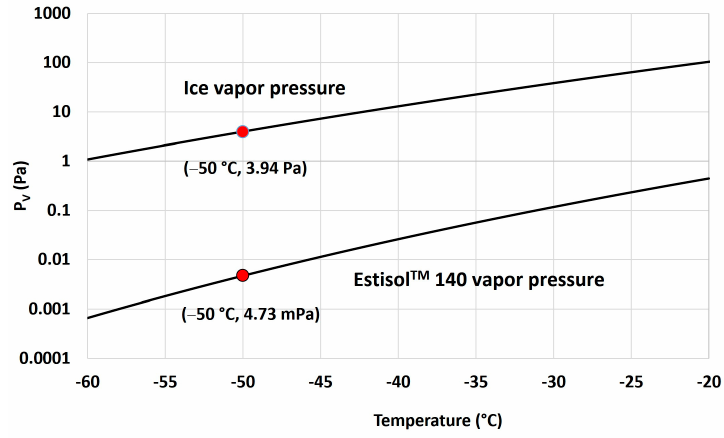
Figure 1. Vapor pressure over ice and Estisol TM 140 as a function of temperature. The plot is in linear-log scales, indicating a fast-growing variation.